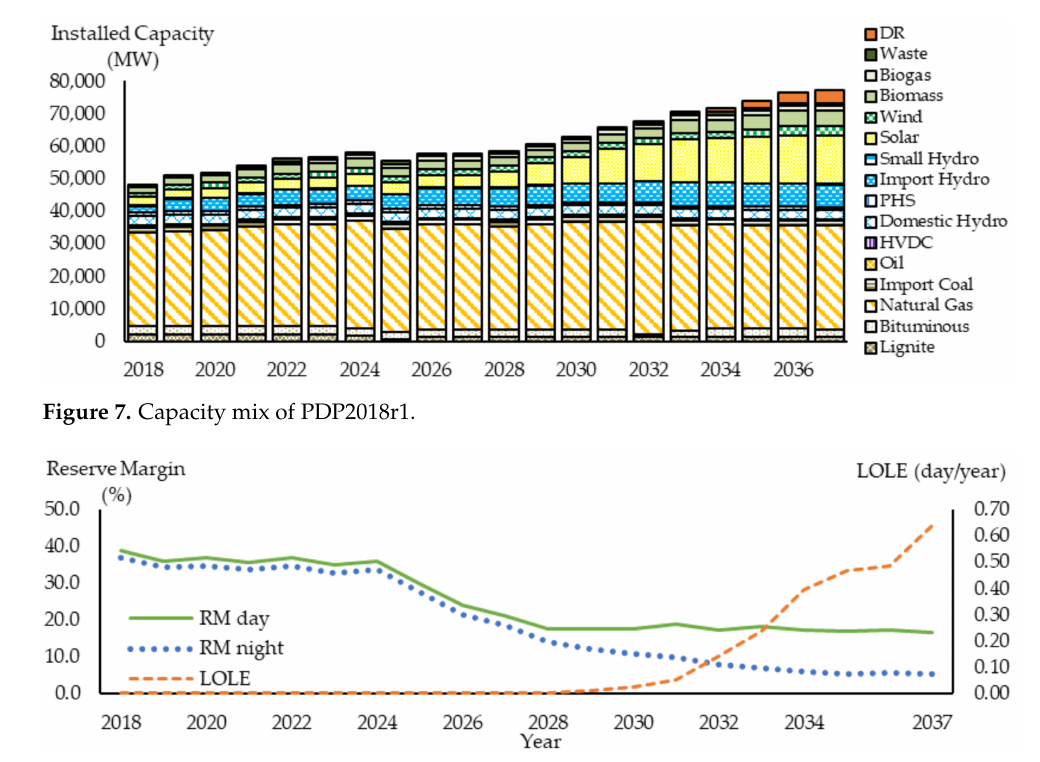
Figure 8. Reliability indices of PDP2018r1.